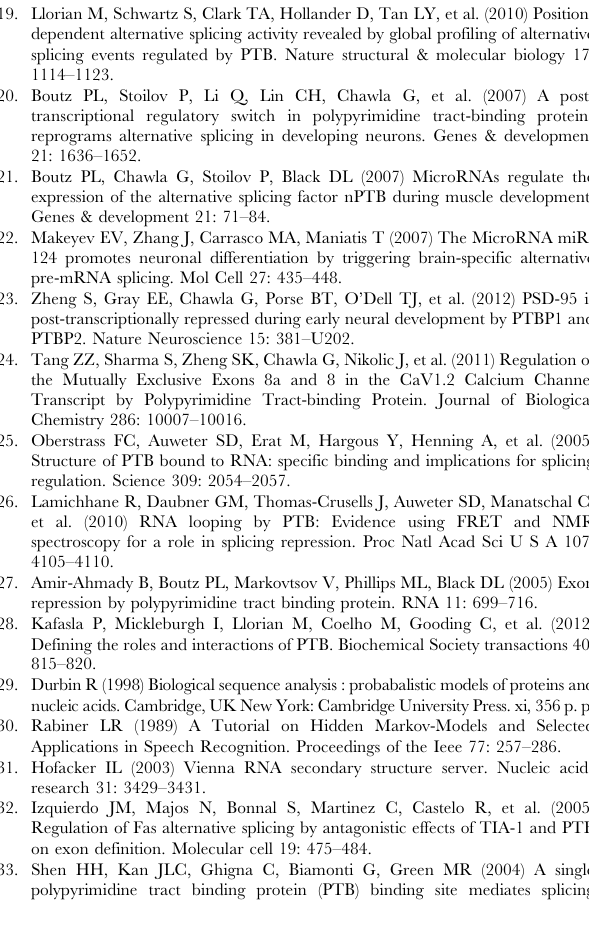
Figure S12 Boxplot of PSI (Percent of Spliced In) values estimated from splicing sensitive microarray data for exons expressed in mouse C2C12 myoblasts. Exons with higher ( . 0.65) and lower ( , 0.2) repression probabilities are compared. Exons used in the original training set were excluded from the plot. The number of exons in the corresponding probability bin is given by n . The p-value was calculated from a one-tailed Student’s t-test. Figure S13 Distribution of PTBP1 binding scores of exons and introns before and after normalization. 168,111 exons and their flanking introns from the set of annotated mouse internal exons were subjected to scoring and normalization. Raw PTBP1 Binding scores are affected by sequence length and base composition. To account differences in these features between introns and exons in normalized scores, we grouped the exons and their upstream and downstream introns separately. The sequences in each group were sorted according to length into bins of 1,000 sequences each. The average scores and standard deviations were determined for each bin. These values were used to transform the raw scores into z-scores for each sequence per bin.